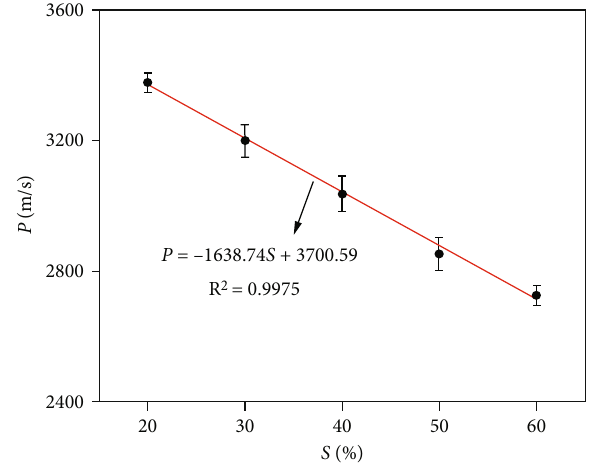
Figure 6: The wave velocity P with S .